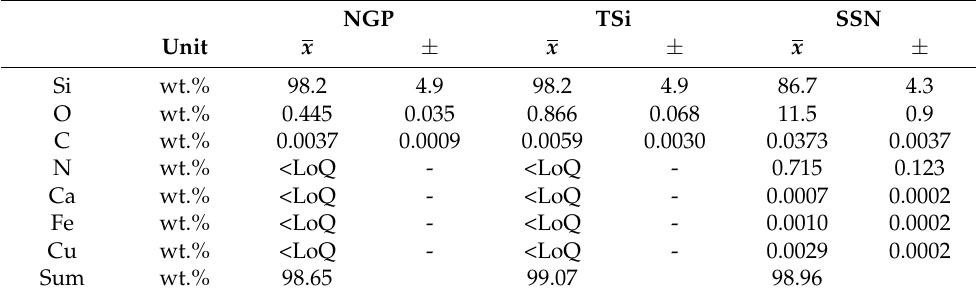
Table 3. Results of chemical analyses for the silicon nanomaterials used, measured by inductively coupled plasma optical emission spectroscopy (ICP-OES), carrier gas hot extraction (CGHE), and carbon and sulfur (CS) analyzer (LoQ: limit of quantification). NGP TSi